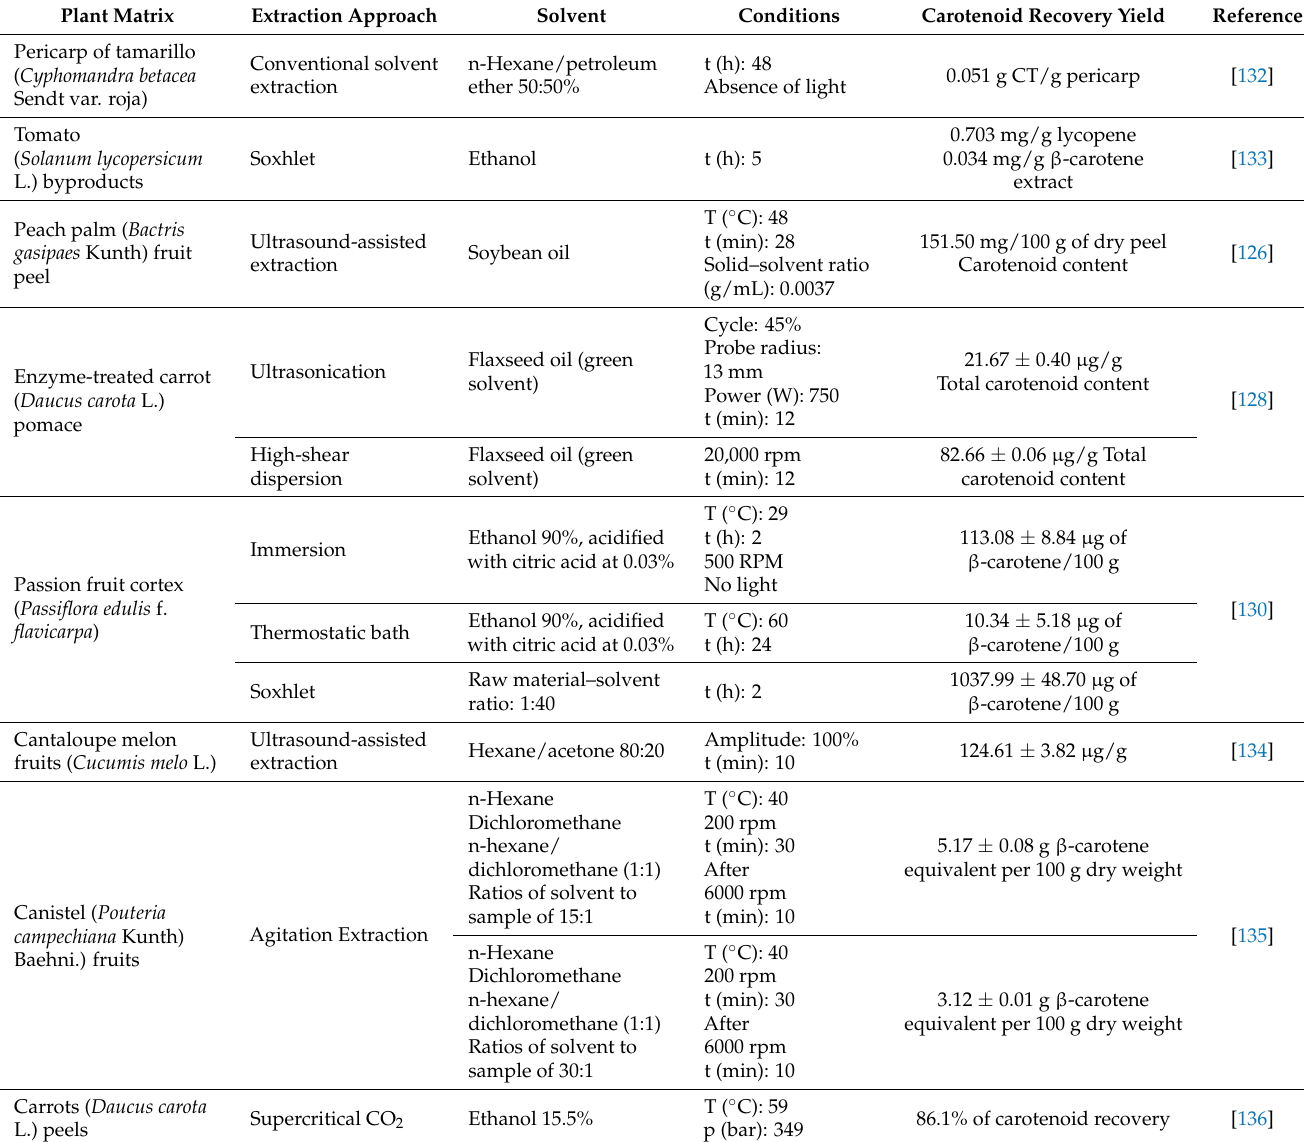
Table 4. Comparison of different methods studied for carotenoid